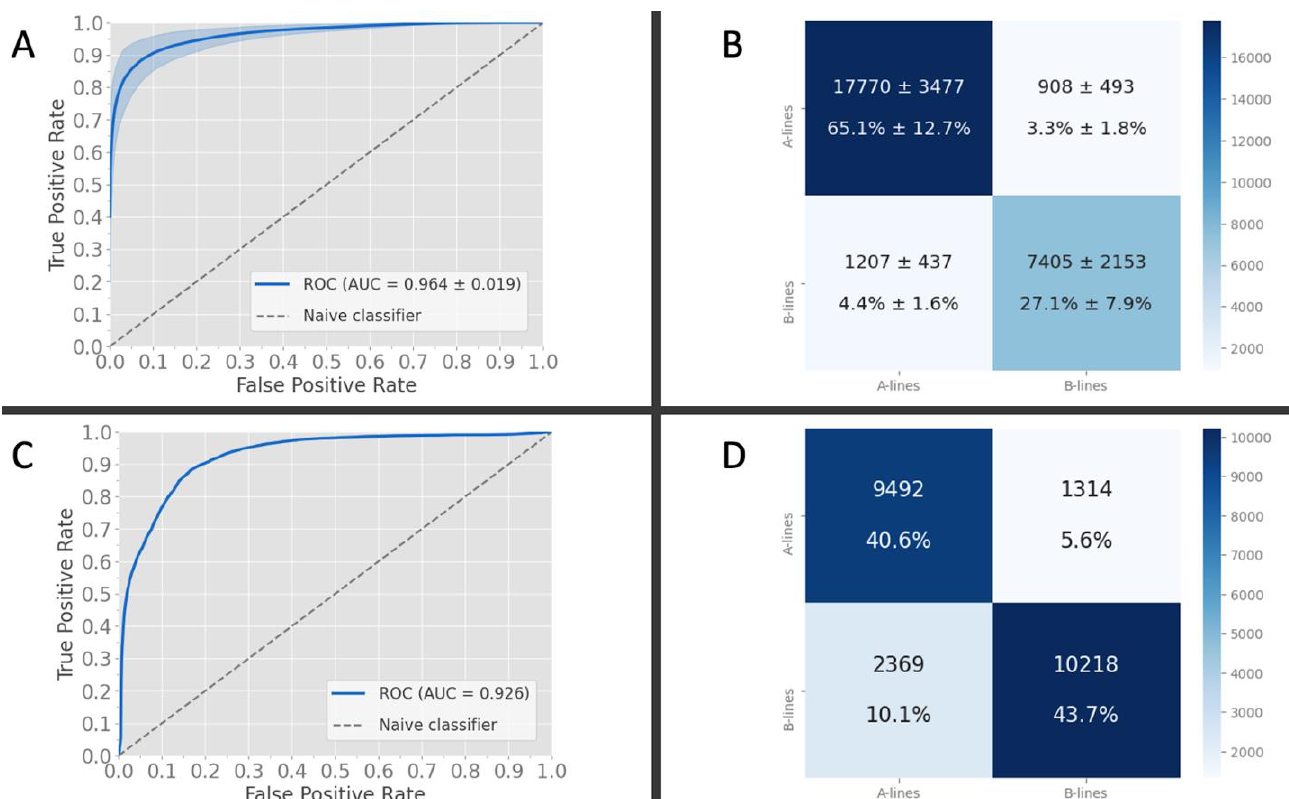
Figure 6. Receiver-operator characteristic curves and confusion matrices for the local ( A , B ) and external ( C , D ) data. ( A ) AUC of the k-fold validation internally gave an average of 0.96 ( ± 0.02) with the corresponding confusion matrix results in ( B ); ( C ) AUC of the frame-based inference on the external data with our trained classifier yielded an AUC of 0.926 with the corresponding confusion matrix in ( D ). Table 4. Summary metrics for a 10-fold cross-validation experiment on our local data and the external data inference. Data